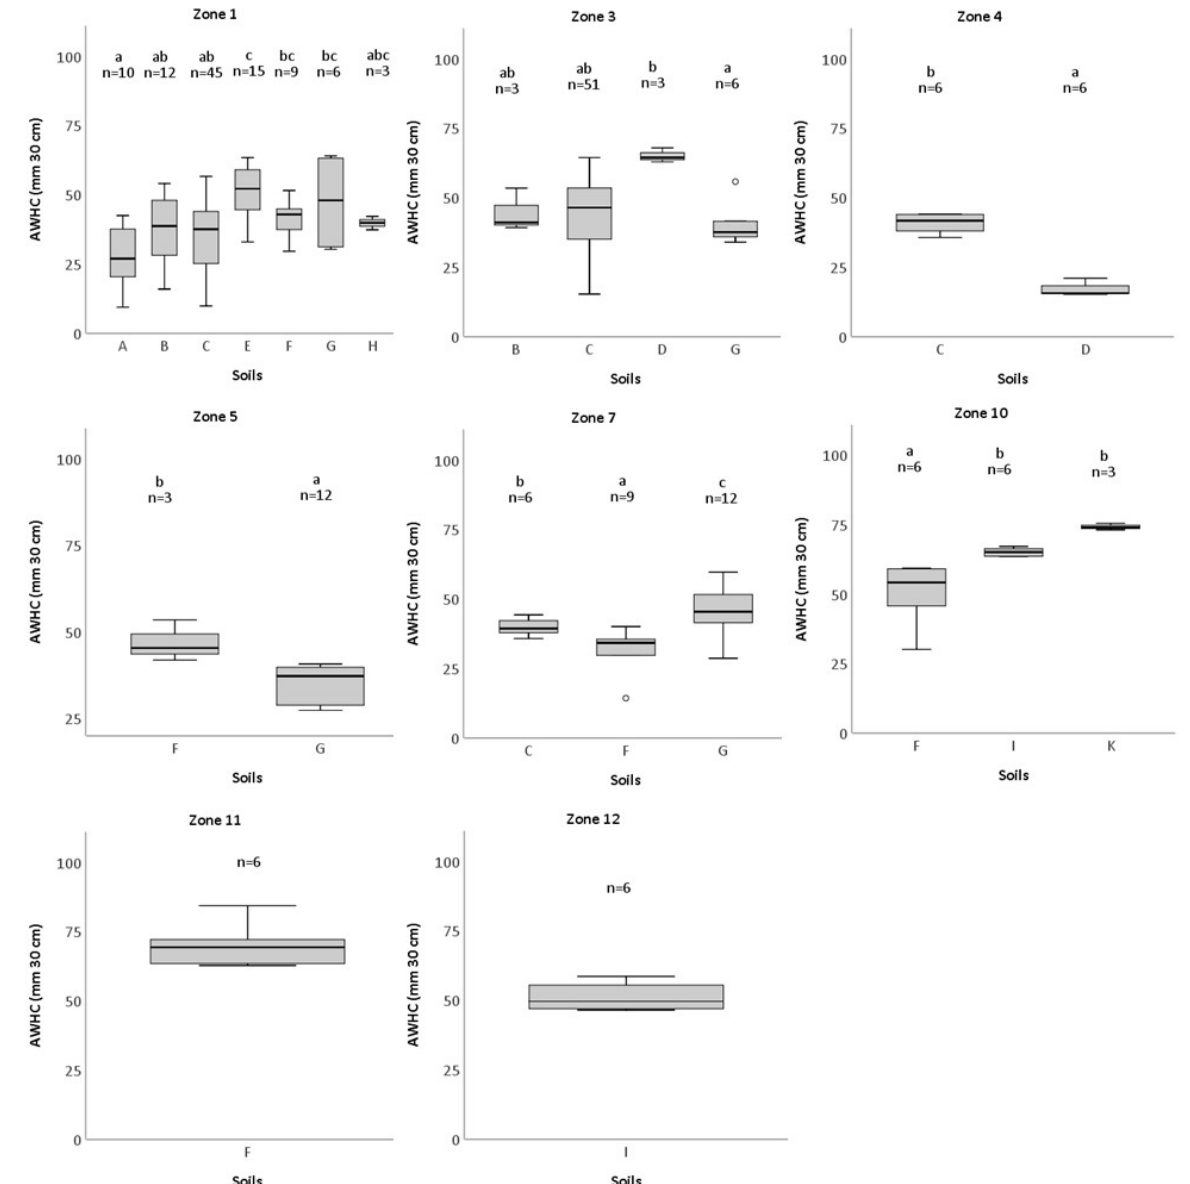
Figure 5. Volumetric soil AWHC in conventionally managed topsoil (0–30 cm) for the different types of soils in each zone selected for this study. Center lines show the medians, box limits indicate the 25th and 75th percentiles, whiskers extend 1.5 times the interquartile range from the 25th and 75th percentiles, outliers are represented by dots. Values showing the same letter belong to the same homogeneous group according to Duncan’s test ( p < 0.05). A: Xerolls, B: Ustolls, C: Xerepts, D: Xerepts with depth limitations, E: Calcids, F: Orthents, G: Fluventic Inceptisols and Entisols; H: Gypsids; I: Udepts, J: Fluventic Udepts, K: Humults [58]. Open circles are outliers.